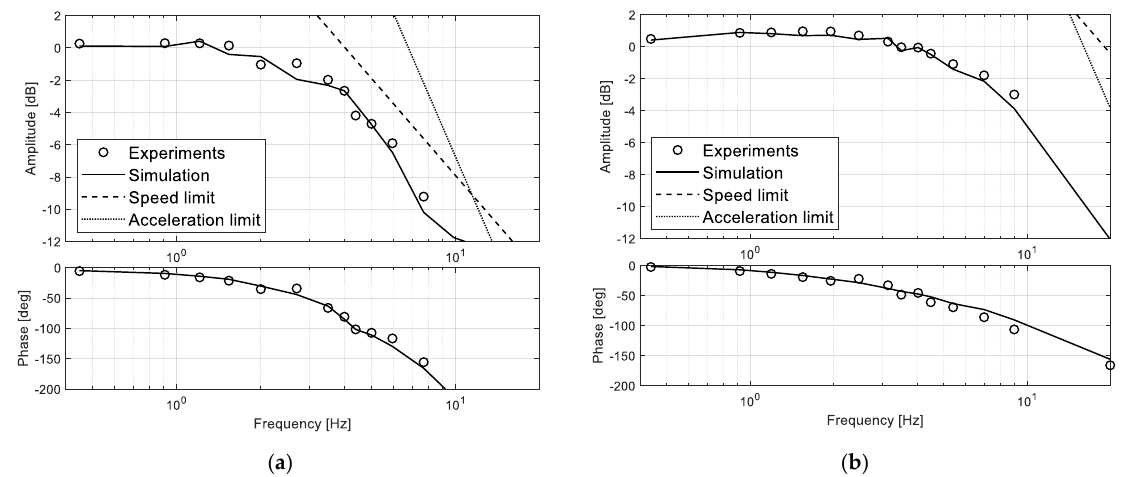
Figure 10. Frequency-domain model validation: position tracking at 1% maximum demand amplitude (0.5 mm), with 2 kN compressive load; ( a ) AAPR mode; ( b ) AAPT mode.